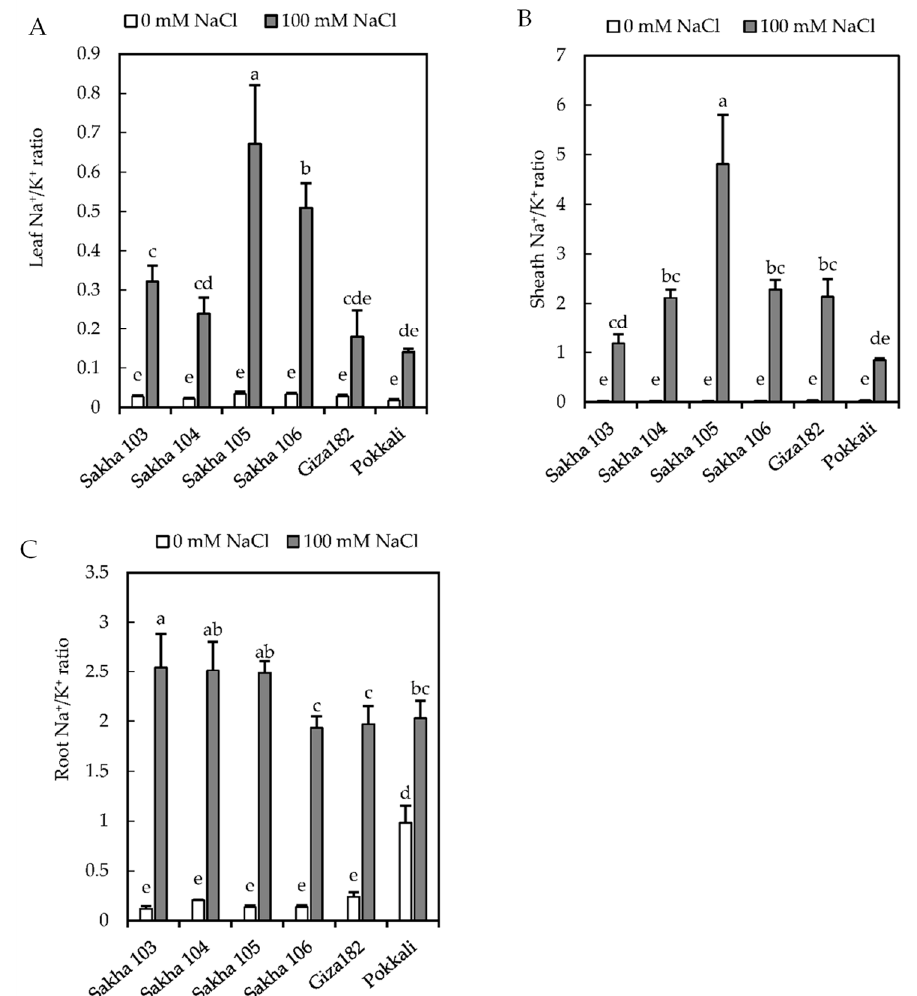
Figure 3. Na + /K + ratio in the leaf blades ( A ), sheaths ( B ), and roots ( C ) of Sakha 103–106, Giza 182, and Pokkali under control conditions and salinity stress at 14 days after treatment. The bars represent means ± SE (standard errors) ( n = 4). The bars with same letter on the top are not significantly different ( p ≤ 0.05).